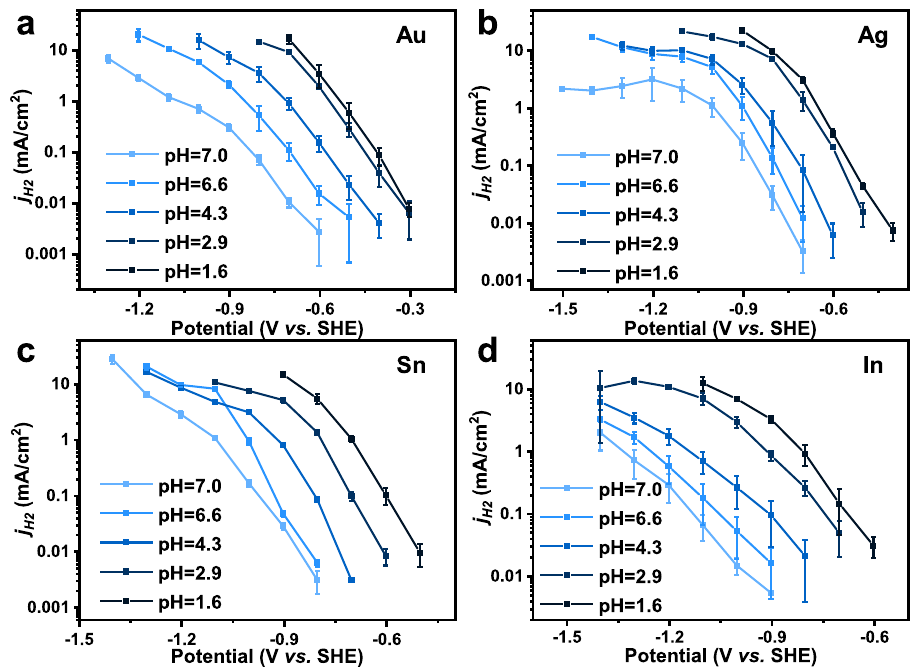
Fig. 2 The pH dependency for HER. The j H2 for Au ( a ), Ag ( b ), Sn ( c ), and In ( d ) catalysts in electrolytes with different pH. Error bars are means ± standard deviation ( n = 3